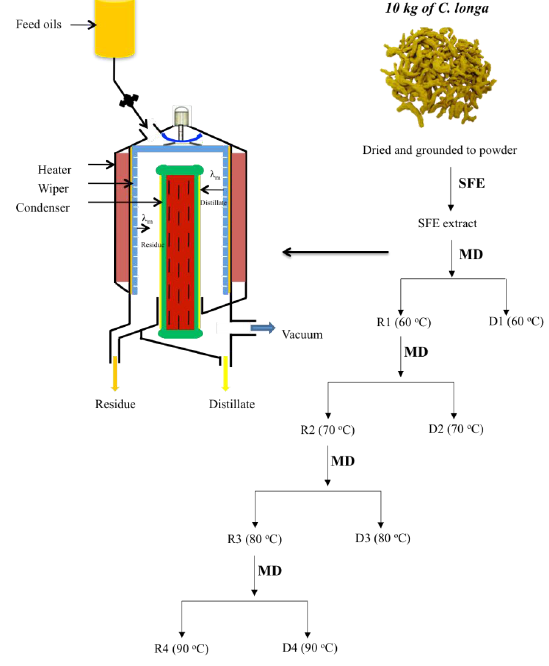
Figure 1. Schematic diagram of wiped film molecular evaporator and scheme of sequential distillation performed by molecular distillation. D1–4: Distillate 1–4, R1–4: Residue